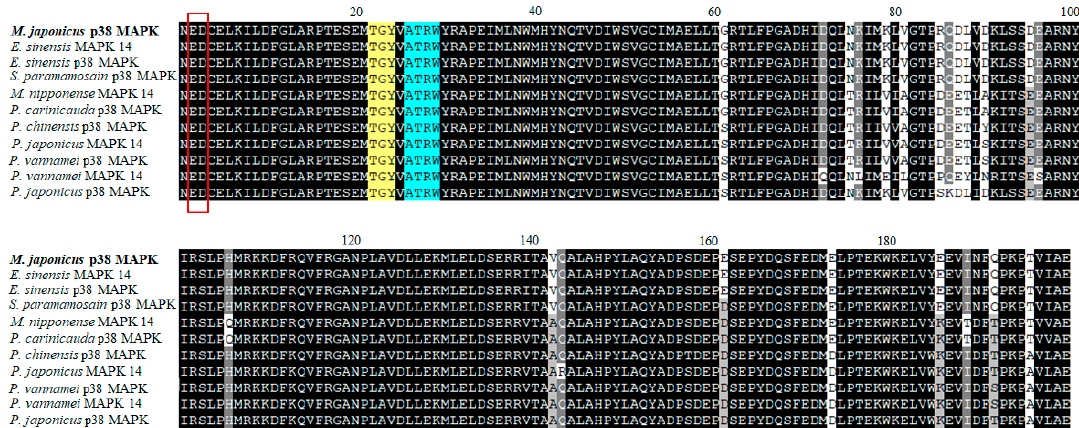
Figure 1. Multiple-sequence alignment of the deduced Macrophthalmus japonicus p38 mitogen-activated protein kinase (MAPK ) gene sequences with the homologous sequences of other crustaceans. Completely conserved residues across all species aligned are shaded in black. The predicted phosphorylation motif TGY (yellow) and the substrate-binding site ATRW (blue) are indicated by color-shaded boxes. The ED site is presented as box.